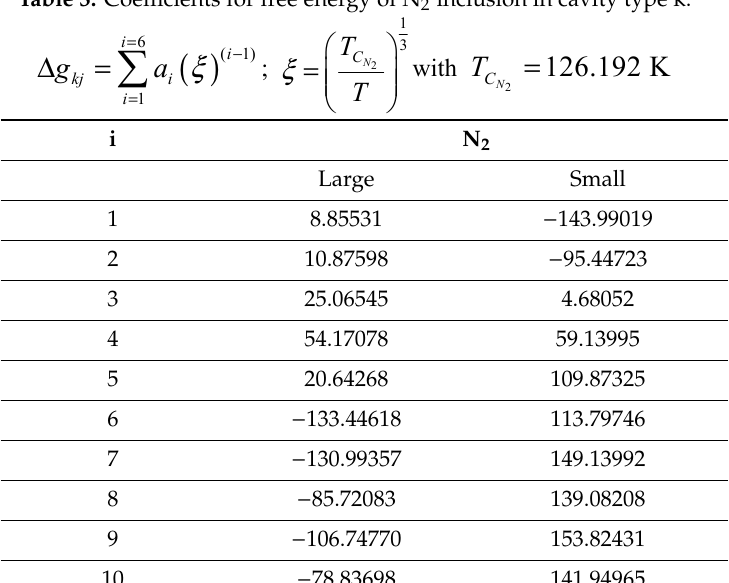
Table 3. Coefficients for free energy of N 2 inclusion in cavity type k. Table 3. Coe ffi cients for free energy of N 2 inclusion in cavity type k.